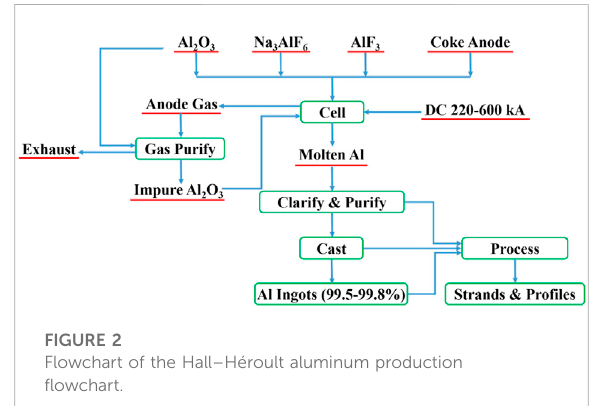
FIGURE 2 Flowchart of the Hall – Héroult aluminum production fl